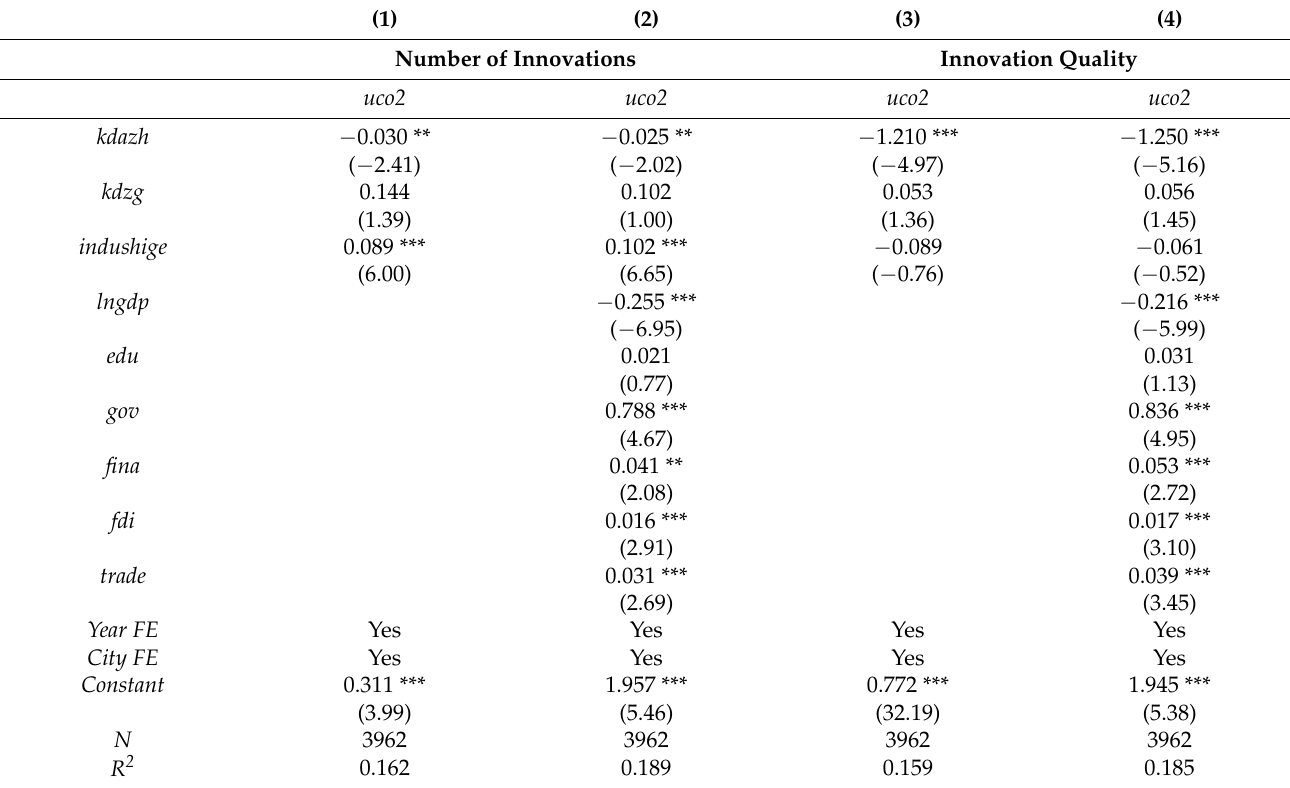
Table 7. Mediation effect test.